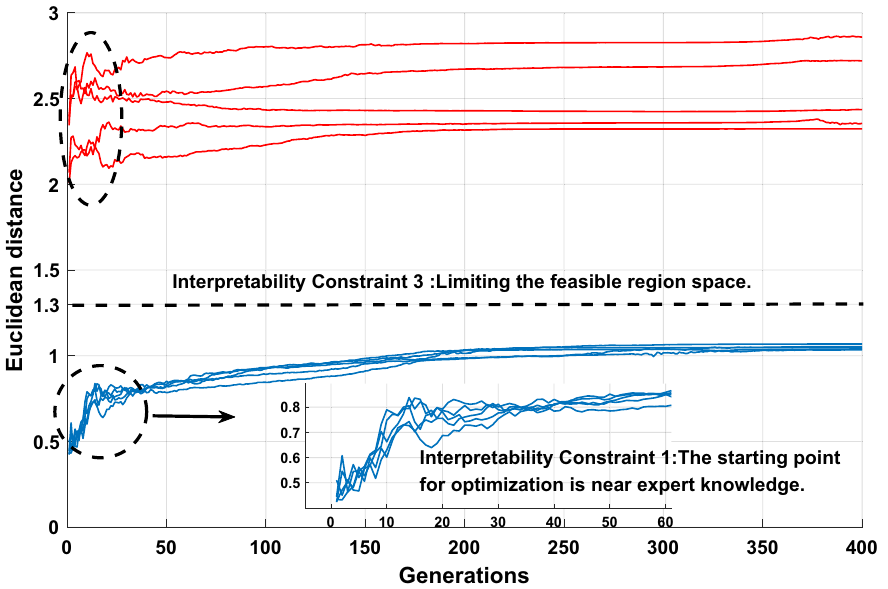
Figure 23. Interpretability analysis of